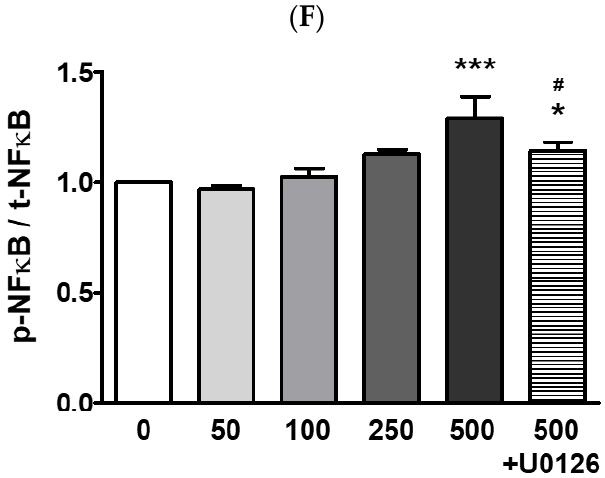
Figure 2. Effect of PM on MAPK and NF κ B proteins in ARPE-19 cells. Cells were treated with 0–500 µ g/mL of PM for 30 min. U0126 (20 µ M) was pretreated for 30 min before PM (500 µ g/mL) exposure. ( A ) Phosphorylation levels of p38, JNK, ERK, I κ B α , and NF κ B were analyzed by western blot. GAPDH was used as the loading control and for normalization. The protein expression ratios of ( B ) p-p38/t-p38, ( C ) p-JNK/t-JNK, ( D ) p-ERK/t-ERK, ( E ) p-I κ B α /t-I κ B α , and ( F ) p-NF κ B/t-NF κ B are shown. Data are portrayed as mean ± SD ( n = 3). Data were analyzed using one-way ANOVA fol- lowed by Tukey’s multiple comparison (* p < 0.05, ** p < 0.01, *** p < 0.001). Asterisk signs were used to indicate comparisons against the vehicle control group. Also, data were analyzed by student’s t - test and pound signs were used for comparisons between the 500 and 500+U0126 groups (# p < 0.05, ## p < 0.01, ### p < 0.001). PM; particulate matter, MAPKs; mitogen-activated protein kinases; p38; p38 MAPK, JNK; c-Jun N-terminal kinase, ERK; extracellular signal- regulated kinases, NFκB; nu- clear factor kappa B p65, IκBα; NFκB inhibitor alpha, GAPDH; glyceraldehyde -3-phosphate dehy- drogenase; p; phosphorylated, t; total.